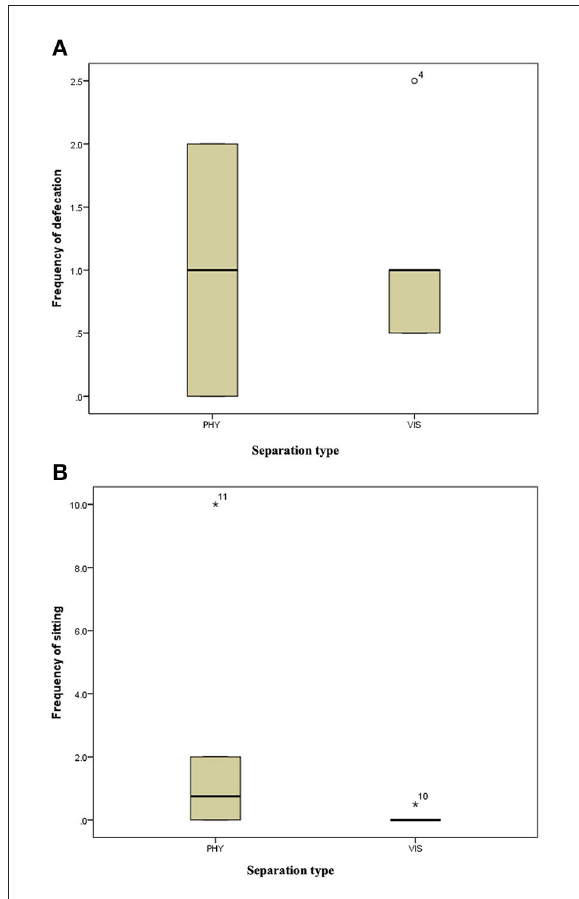
FIGURE5 (A) Frequency of defecation of the mother hens when subjected to 10-min physical (PHY) or visual (VIS) separation from their chicks. (B) Frequency of sitting of the mother hens when subjected to 10-min physical (PHY) or visual (VIS) separation from their chicks.